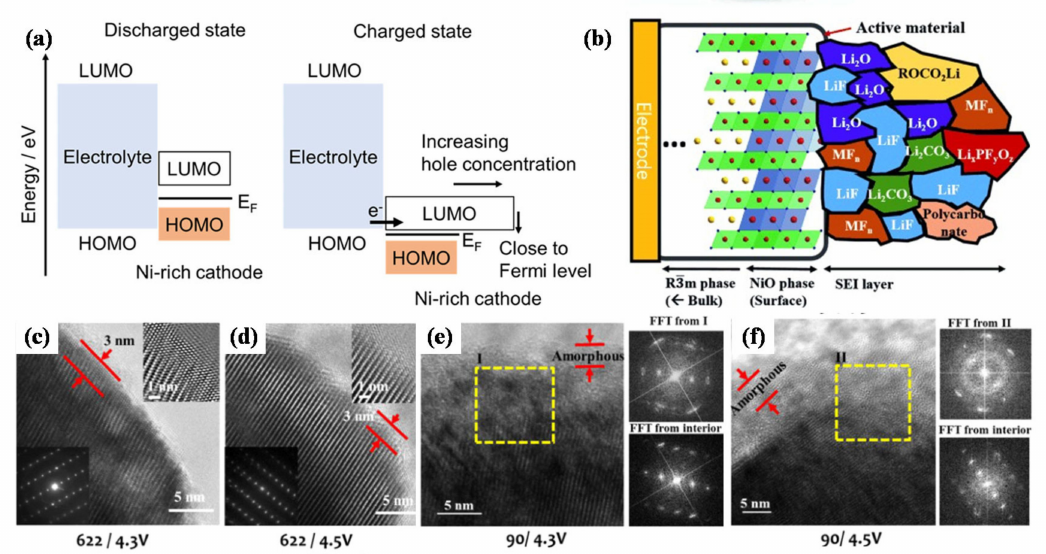
Figure 2. ( a ) LUMO and HOMO energy level diagrams of the Ni-rich cathode and electrolyte. Reproduced with permission from ref. [30]. Copyright 2020 American Chemical Society. ( b ) Schematic diagram of CEI film composition on Ni-rich cathode surface. Reproduced with permission from ref. [31]. Copyright 2015 John Wiley and Sons. TEM surface images and Fourier transform (after 100 cycles) for ( c ) NCM622 charged to 4.3 V, ( d ) NCM622 charged to 4.5 V, ( e ) NCM900505 charged to 4.3 V, ( f ) NCM900505 charged to 4.5 V. Reproduced with permission from ref. [32]. Copyright 2017 American Chemical